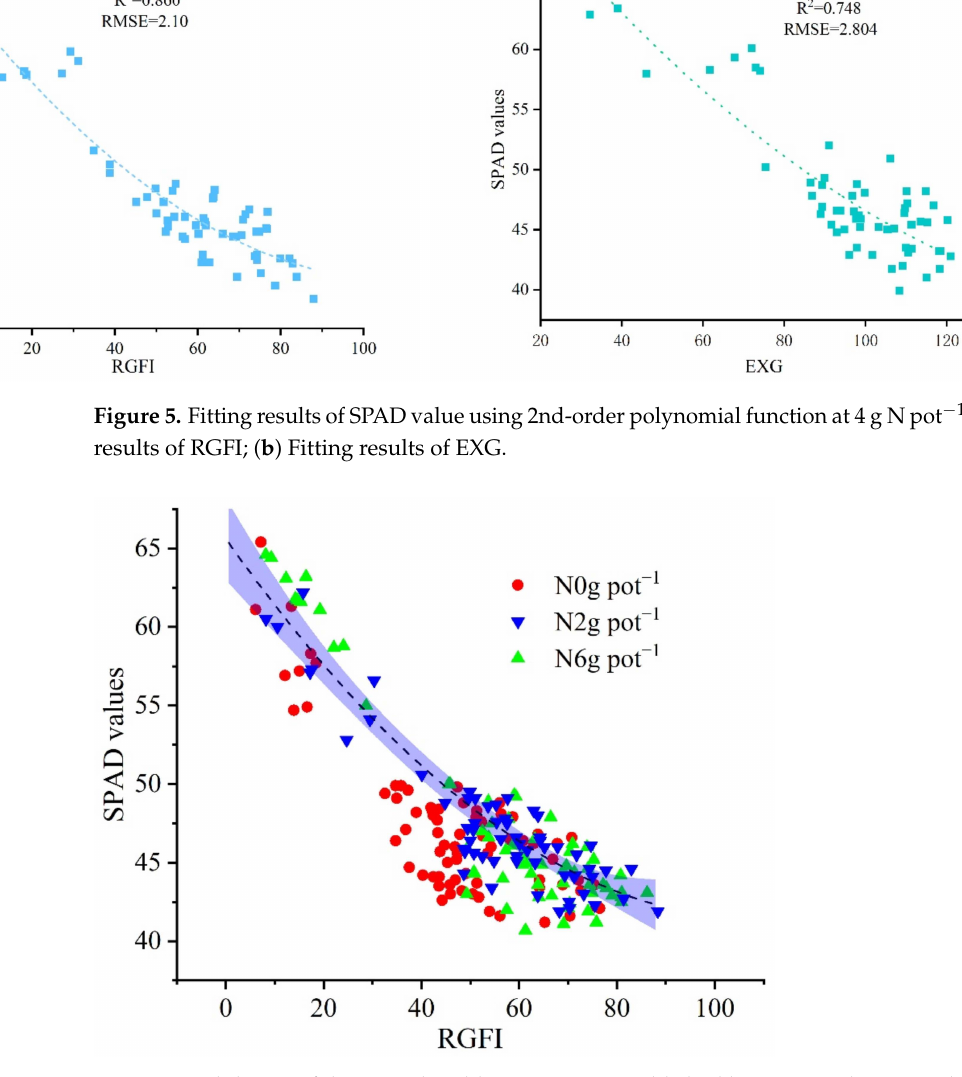
Figure 6. Validation of the critical N dilution curves established by RGFI and SPAD